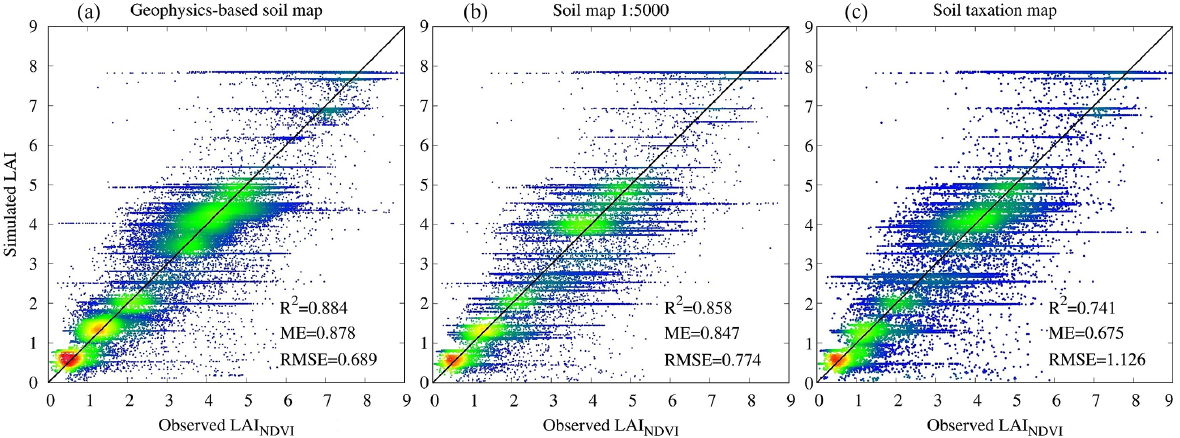
Figure 7. Pixel-by-pixel comparison between simulated LAI and observed LAI NDVI for simulations based on (a) the geophysics-based soil map, (b) the 1:5000 soil map, and (c) the soil taxation map. The colour indicates the density of events, with red representing the highest density and blue the lowest